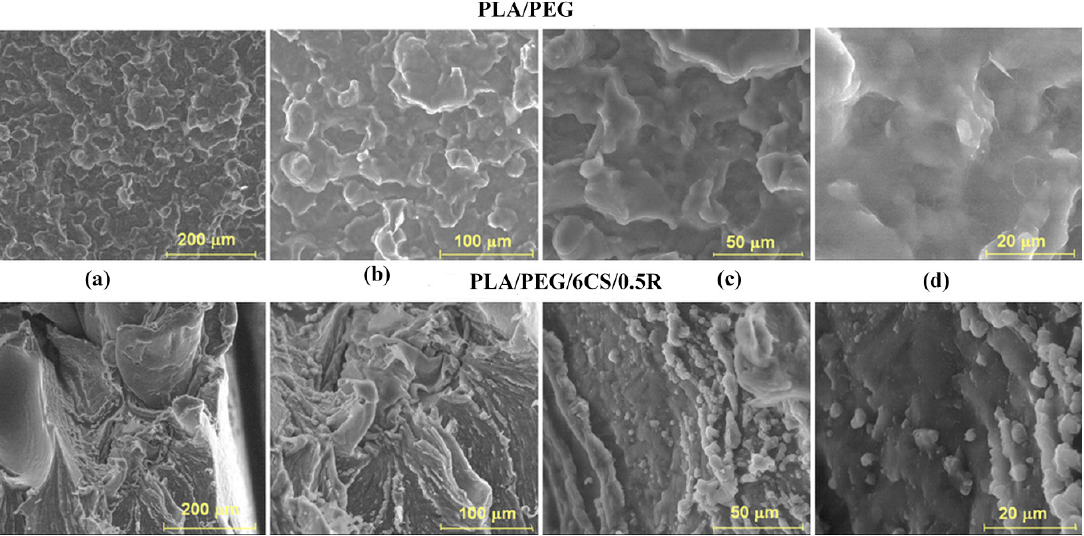
Figure 2. SEM images of poly(lactic acid) (PLA) / polyethylene glycol (PEG) and PLA / PEG / chitosan (CS) / rosemary extract (R) samples at di ff erent magnifications: ( a ) 200 µ m; ( b ) 100 µ m; ( c ) 50 µ m and ( d ) 20 µ m indicated on